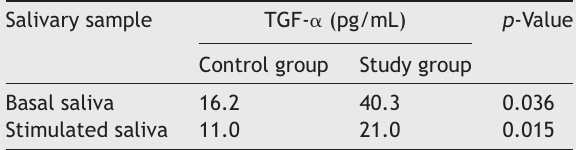
Levels of transforming growth factor alpha (TGF- (cid:2) ) in basal and stimulated saliva samples after chewing parafilm-M in the group of patients with Sjögren’s syndrome and confirmed laryngopharyngeal reflux (study group)